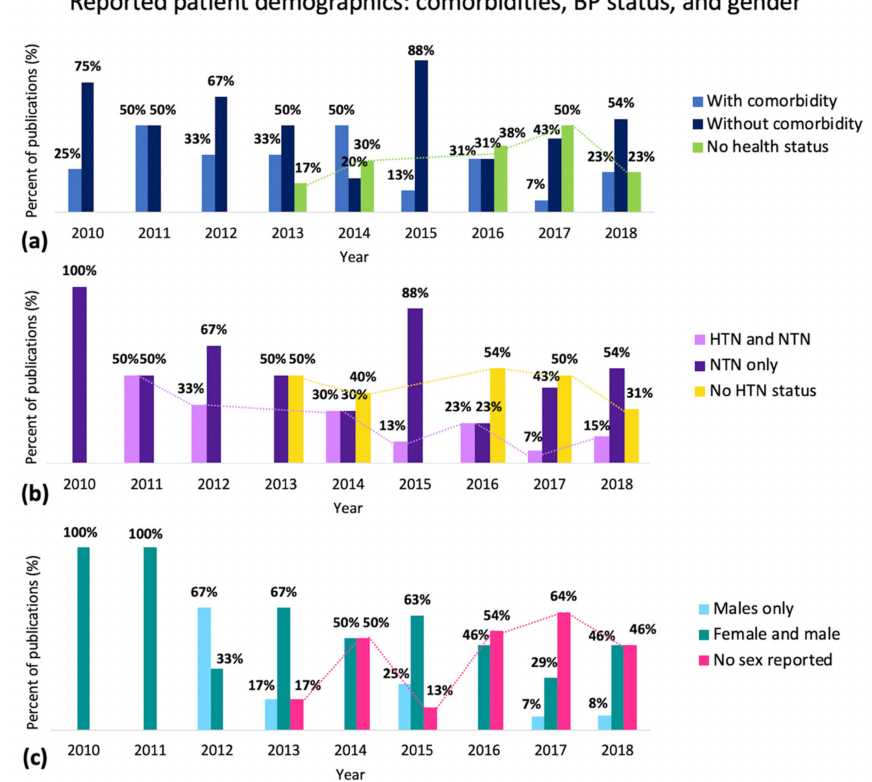
Figure 6. Patient demographics regarding health status, BP status, and gender reported in studies published from 2010–2019. ( a ) With comorbidity: reported diagnosed diseases in their participants. Without comorbidity: tested only healthy participants. No comorbidity reported: it was not reported if the subjects were normotensive vs. hypertensive and if the subjects had comorbidities or not. ( b ) HTN and NTN: documented number of subjects with and without hypertension. NTN only: only included healthy subjects. No HTN Status: did not disclose the BP status of their subjects. ( c ) Males only: tested only males. Female and male: tested both females and males. No gender reported: did not report the gender of their